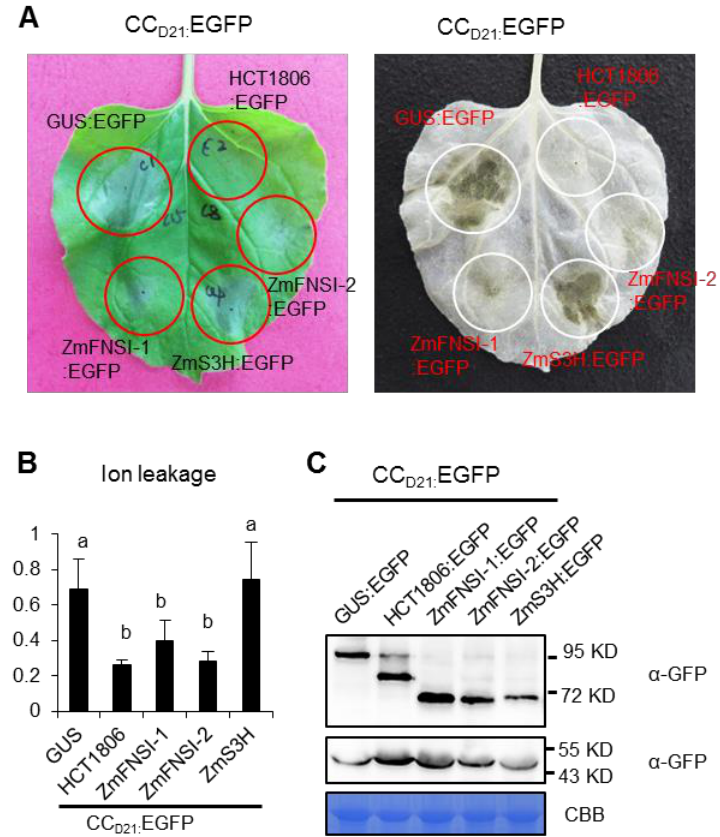
Figure 5. Investigating the function of ZmFNSIs and ZmS3H in CC D21 induced HR. ( A ) ZmFNSIs and ZmS3H were transiently co-expressed with CC D21 into N. benthamiana . The representative leaf was photographed at 3 days after inoculation (left), and the same leaf was cleared by ethanol (right). ( B ) Ion leakage conductivity (average ± SE, n > 5) was measured at 61 h after co-expression of GUS, HCT, ZmFNSIs or ZmS3H with CC D21 . Significant di ff erences ( p < 0.05) between samples are indicated by di ff erent letters (a–b). ( C ) Total protein was extracted from agro-infiltrated leaves at 30 hpi. Anti-GFP was used to detect the expression of GUS, HCT, ZmFNSIs and ZmS3H. Equal loading of protein samples was shown by CBB staining of Rubisco.